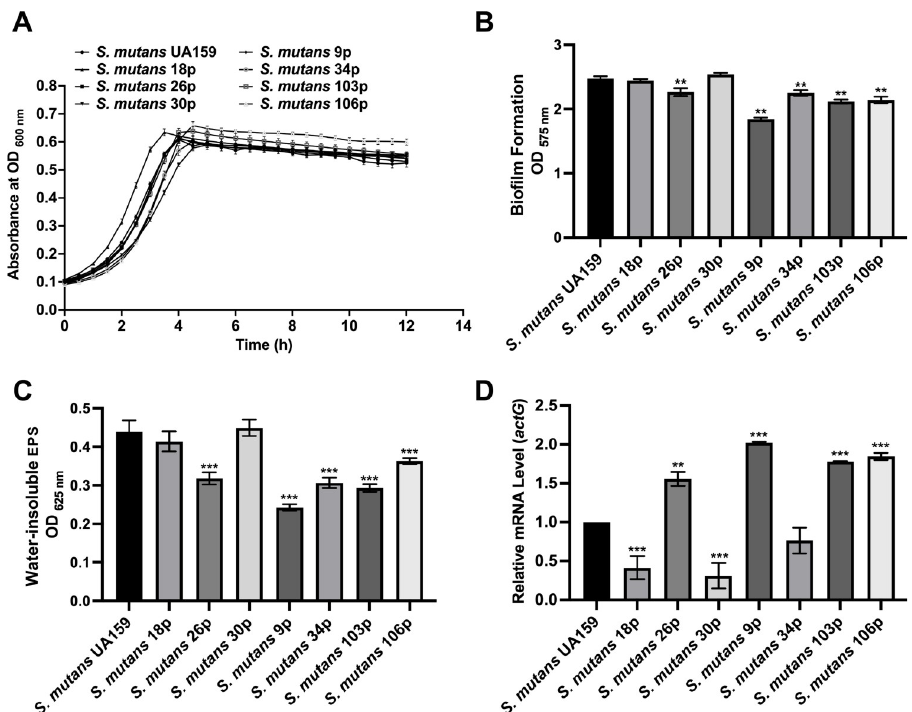
Fig 6. Effect of actG on clinically isolated strain s . (A) Growth curves of S . mutans UA159 and clinically isolated strains in anaerobic condition for 12 h. (B, C)The biofilm biomass was determined by crystal violet staining assay (B) and anthrone-sulfuric acid method (C) when cultured in BHIS (1% sucrose wt/vol) in anaerobic condition for 24h. (D) Gene expression level of actG in clinically isolated strains was determined by quantitative RT-PCR and calculated using the 2 - ΔΔ Ct method with values normalized to the reference gene 16S rRNA. Results are presented as mean ± SD ( �� P < 0.01 or ��� P < 0.001).